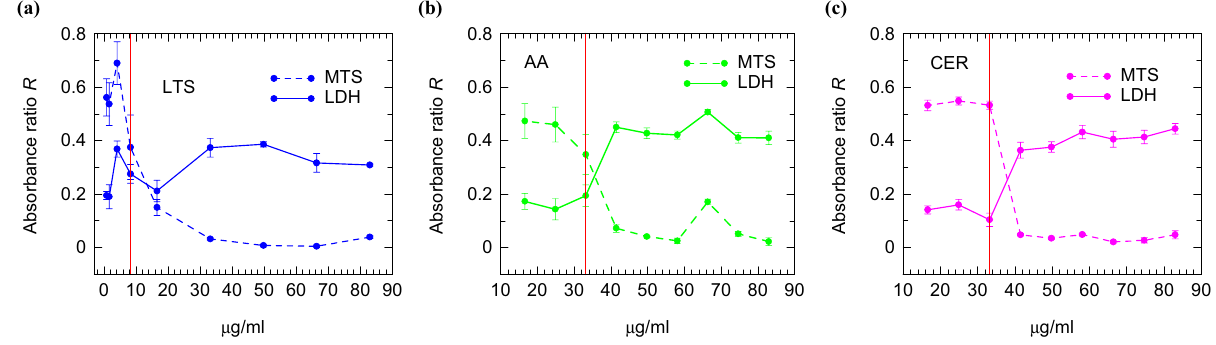
Figure 4. The absorbance ratio R in MTS and LDH cytotoxicity tests on HS27 cell line for dilutions prepared from stock solutions of 8.3 mg/ml of three types of MgB 2